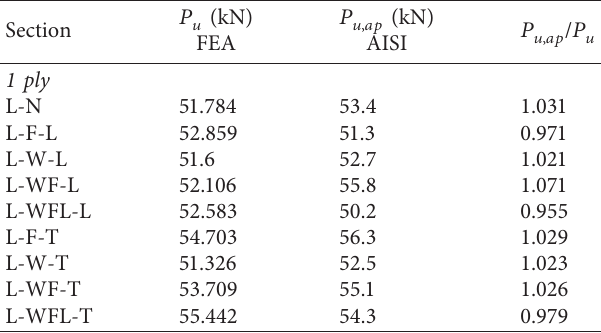
Table 9: Load estimates, for the long columns.